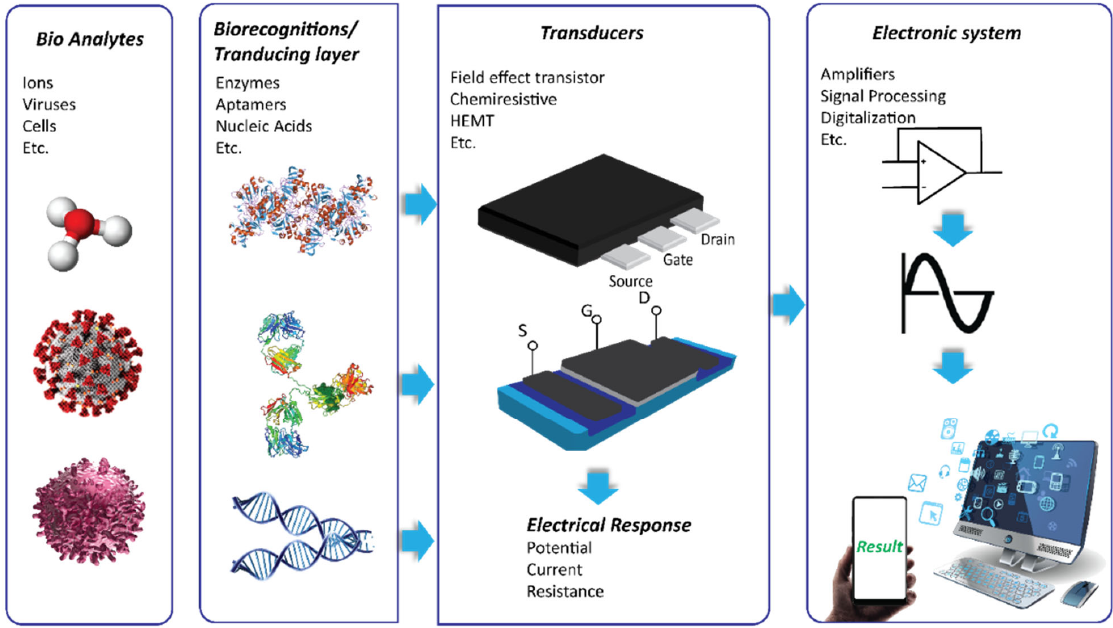
Figure 1. Scheme of a chemical and biosensor comprising of recognition element (receptor) on transducer to selectively recognize target of interest. The transducer changes the biorecognition event on its surface into a measurable signal before sending it for signal processing, which can be read by the end ‐ user.